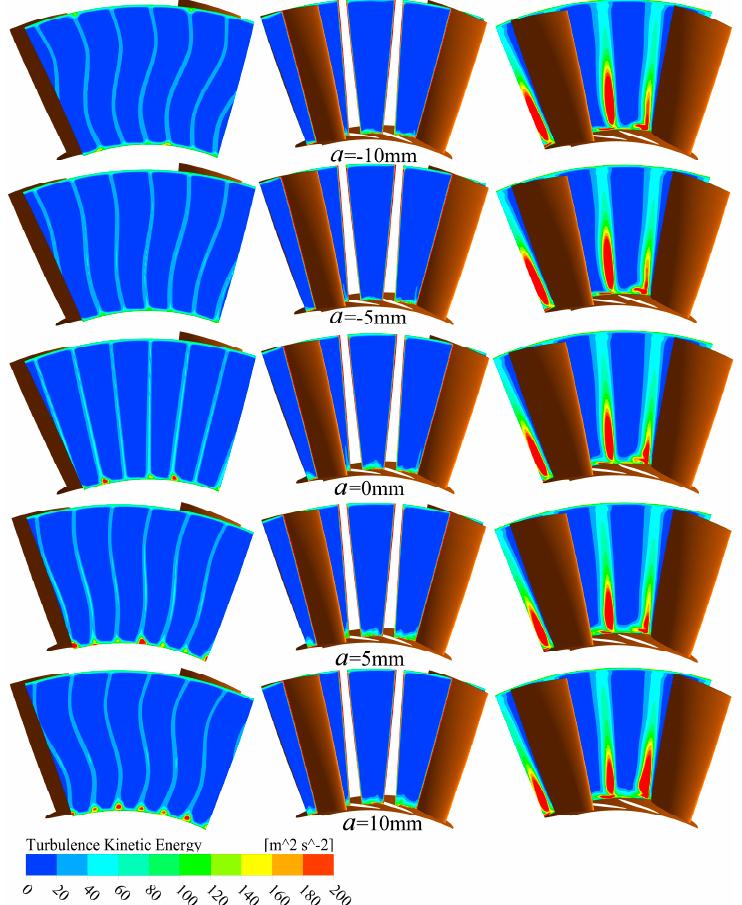
Figure 15. Turbulent kinetic energy distribution of di ff erent models under near-blockage condition.